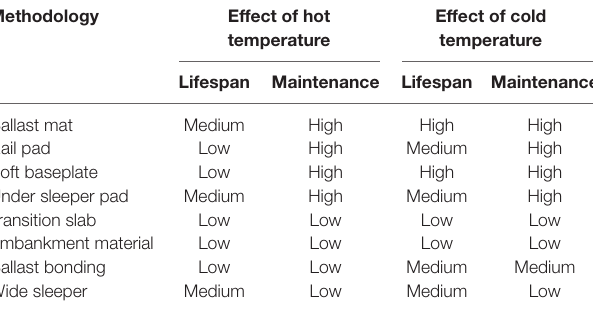
TaBle 1 | Effect of temperature to bridge approach material and